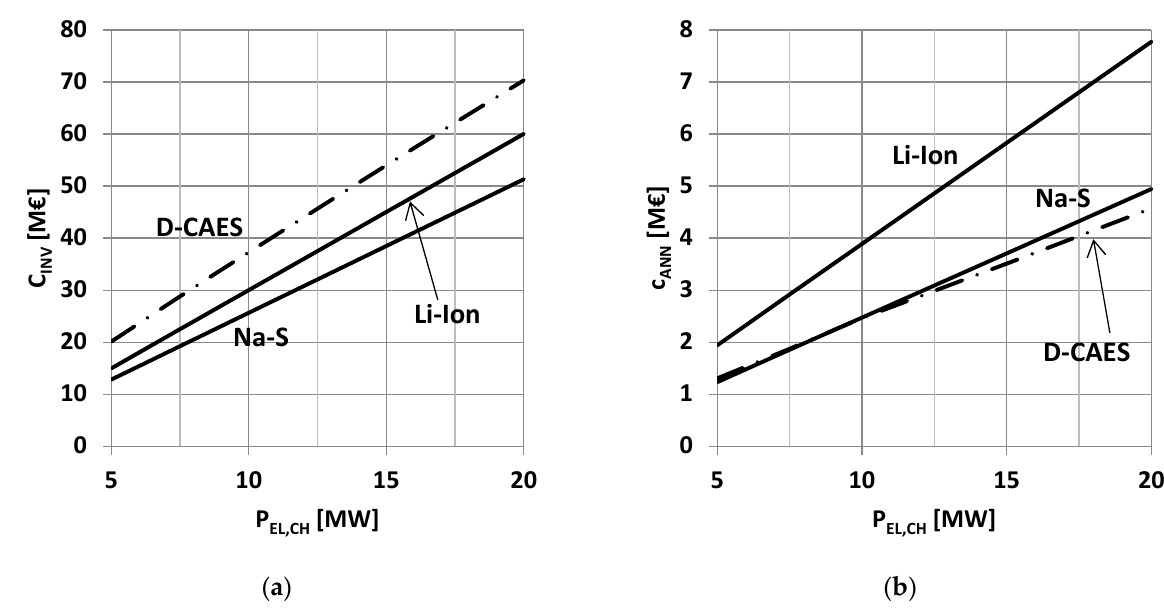
Figure 3. Investment expenditure by varying the rated charging power for storage systems under comparison. Case t CH = t DS = 10 h: ( a ) Investment cost ; ( b ) Annualized capital cost.